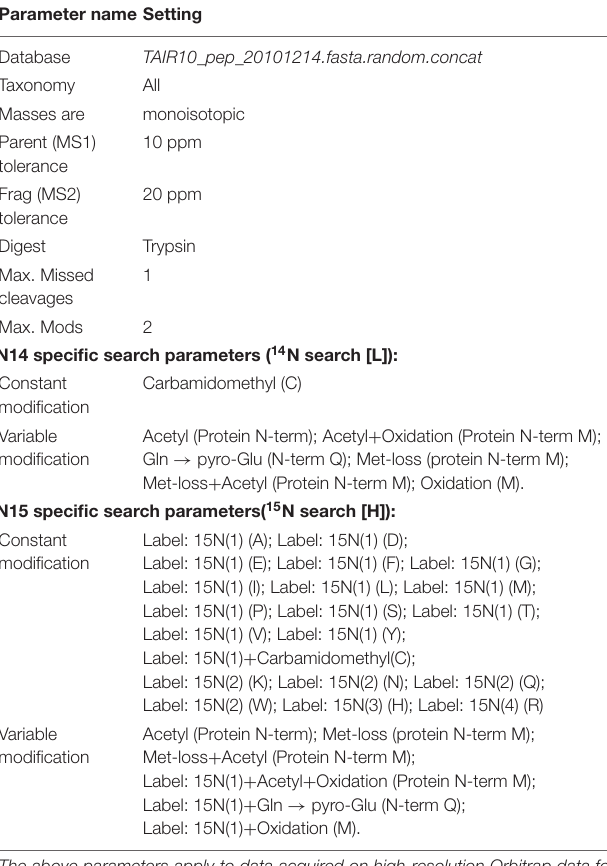
TABLE 1 | Search parameters for 14 N light- and 15 N heavy-labeled